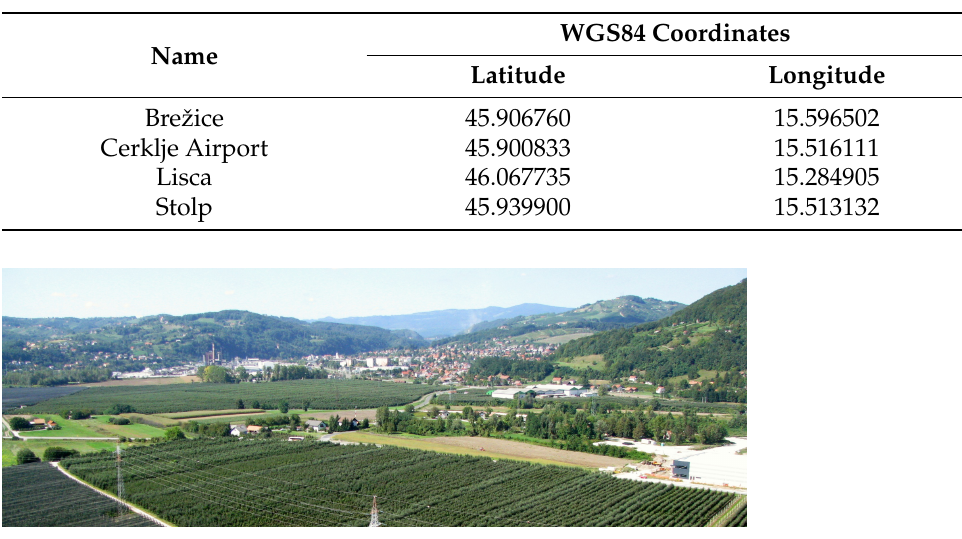
Table 2. Locations of meteorological stations.